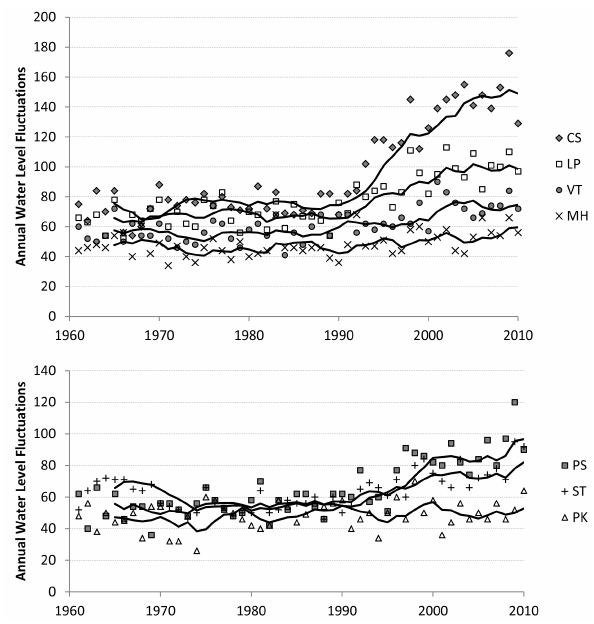
Figure 6. Number of annual water level fluctuations for each moni- toring station between 1961 and 2010. Solid lines indicate a 5-year moving average for each station: Chiang Saen (CS), Luang Prabang (LP), Vientiane (VT), Mukdahan (MH), Pakse (PS), Stung Treng (ST), and Prek Kdam